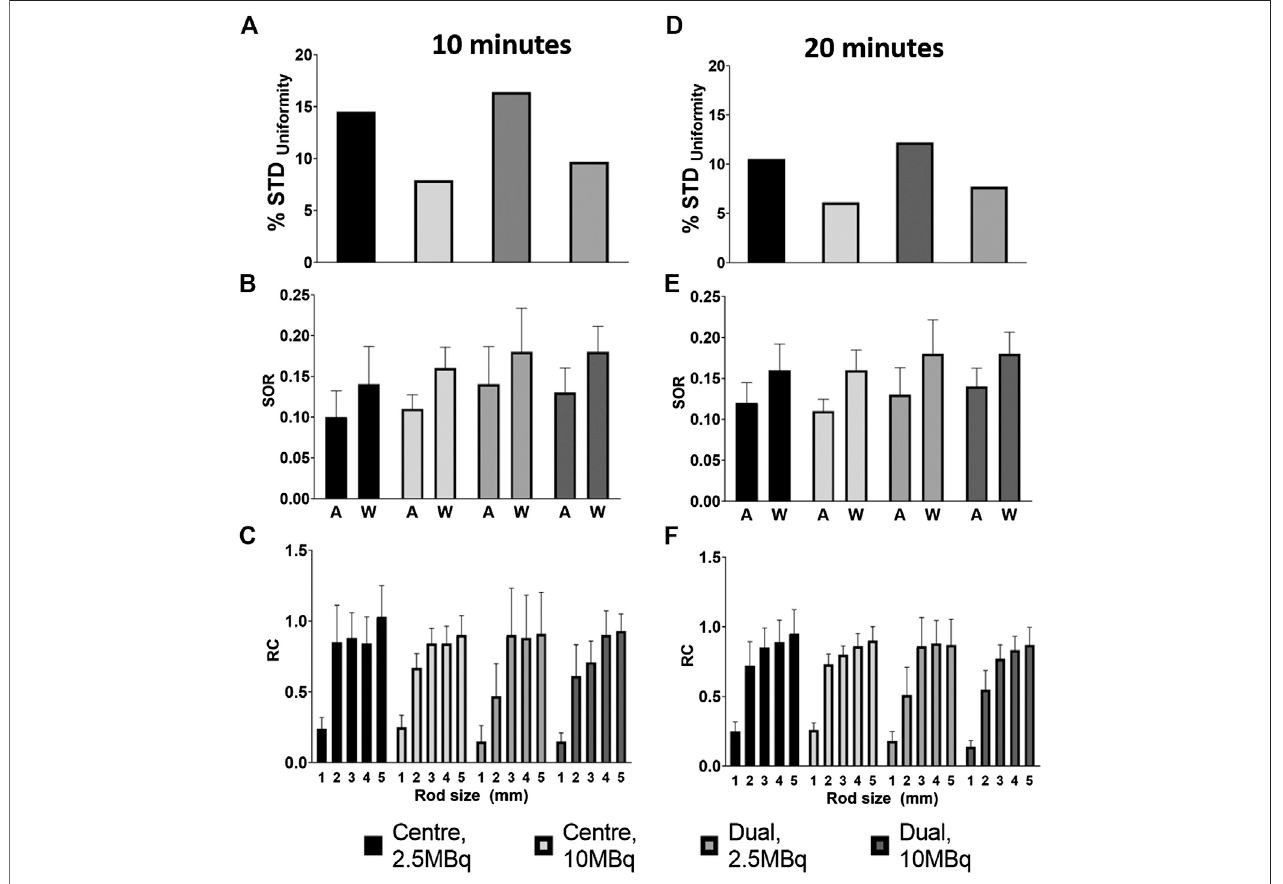
FIGURE 5 | Assessment of NEMA NU4 Image Quality for the 10 and 20 min summed frames for single centered and dual phantom cases. (A – C) Uniformity, SOR and Recovery Coef fi cients for the centered and dual phantom positions, 10 min summed frame. (D – F) Uniformity, SOR and Recovery Coef fi cients for the single or dual phantom positions, 20 min summed frame. Error bars (cid:2) standard